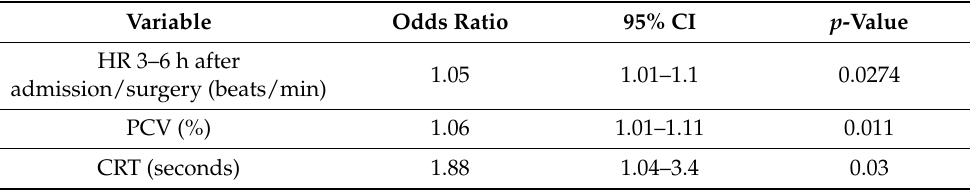
Table 5. Significant results of the multivariate logistic regression model used to evaluate the asso- ciation between the independent variables and the outcome (=not discharge) in 157 horses admit- ted for colic syndrome at the Veterinary Teaching Hospital of Teramo (PCV: packed cell